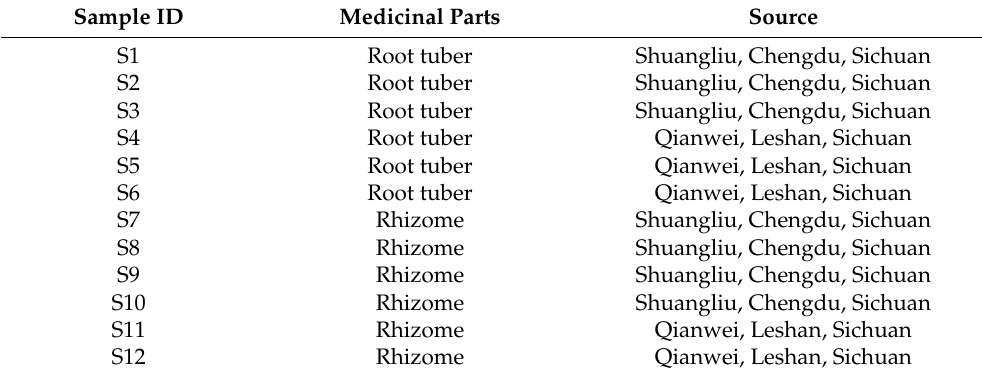
Table 5. Basic information of RCL and RHCL